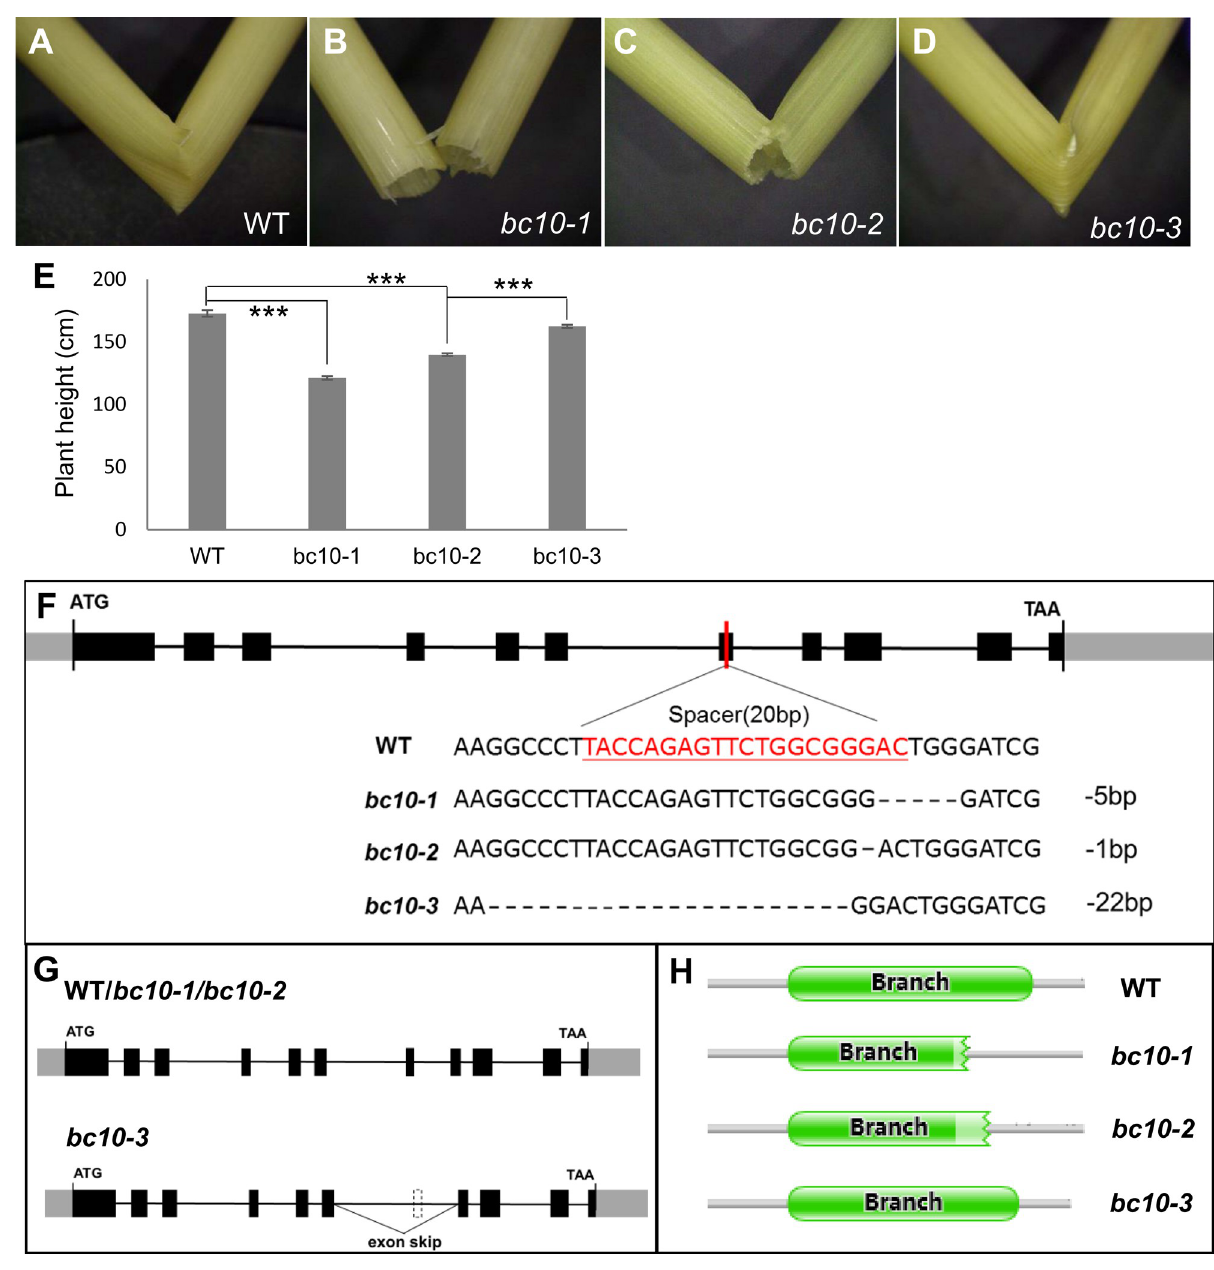
Fig 5. Phenotype, genotype and transcript analysis in wild type and bc10 mutants. (A-D) Compared with the wild type, the stem of bc10-1 and bc10-2 were easily broken, while bc10-3 was not. (E) Plant height of wild type and mutants. Sample size was N = 6, 24, 22, 29 or WT, bc10-1 , bc10-2 , bc10-3 respectively (F) Genotypes of wild type and mutants. (G) The major transcripts found in WT/ bc10-1 / bc10-2 and bc10-3 . Number of positive monoclones sequenced through TA cloning: WT (23), bc10-1 (22), bc10-2 (44) and bc10-3 (50). Note that the skipped exon in bc10-3 is a multiple of three long hence frame preserving on skipping. (H) Prediction of BC10 protein domain by the Pfam. Error bar: mean +/- sem. Significance tests: two tailed t-test, � P � 0.05, �� P � 0.005, ��� P �